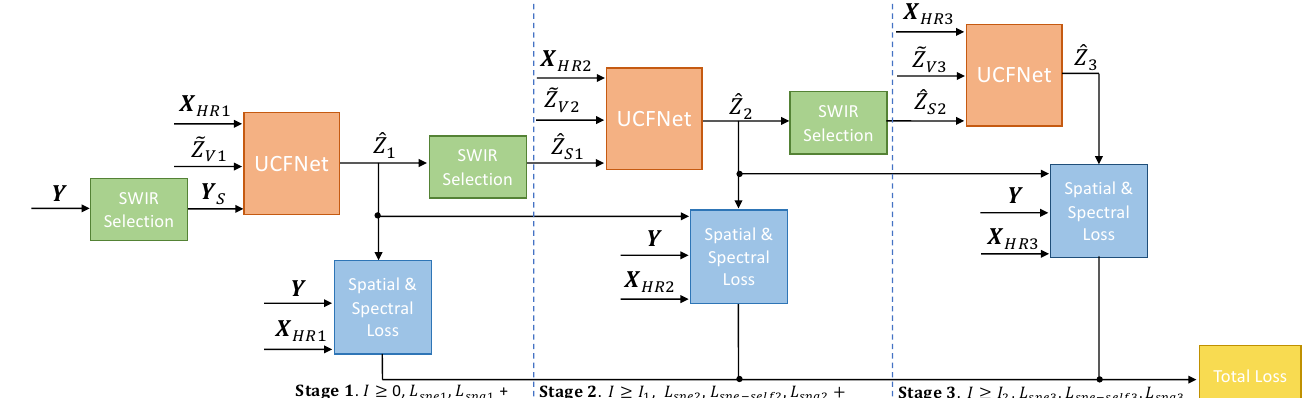
Figure 3. The cascade sharpening strategy. Y is the LR-HSI and Y S is the VNIR part of Y . { X HR 1 , X HR 2 , X HR 3 } is the HR-MSI pyramid. { ˜Z V 1 , ˜Z V 2 , ˜Z V 3 } are the preliminary HR-VNIR-HSIs. { ˆZ 1 , ˆZ 2 , ˆZ 3 } are the sharpened image at each stage. ˆZ S 1 and ˆZ S 2 are the SWIR parts of ˆZ 1 and ˆZ 2 . L spe denotes the spectral loss, L spe − self denotes the self-supervising loss, and L spa denotes the spatial loss. In stage one, three inputs X HR 1 , ˜Z V 1 and Y , are passed into the generator to obtain ˆZ 1 . The spatial resolution of ˆZ 1 is improved by a factor of 2 comparing to Y . L spa spatial loss, which is obtained by calculating the errors between X HR 1 and the